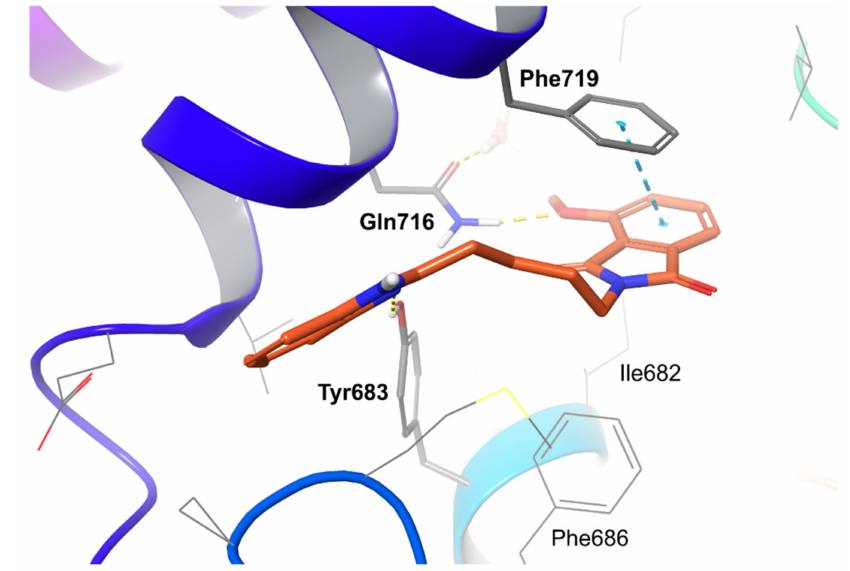
Figure 4. The predicted binding mode of compound 18 in the active site of phosphodiesterase 10A (PDB ID: 3SNI). Crucial interactions of the compound in the catalytic site with Gln716 and Phe719, as well as its positioning in the selectivity pocket (Tyr683) predict inhibitory activity of the series of rationally-designed derivatives synthesized in this study. Amino acid residues engaged in ligand binding (within 4 Å from the ligand atoms) are displayed as sticks, whereas crucial residues, e.g., forming H-bonds (dotted yellow lines) or π - π stacking (dotted cyan lines), are represented as thick sticks. The 2,3-dihydro-1 H -isoindole-1,3-dione moiety, bound in the catalytic active site, interacted